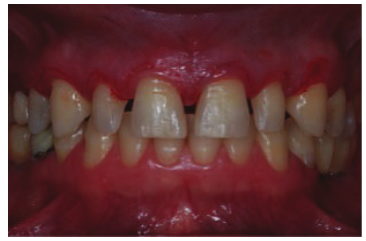
Figure 6: Register of new gingival margin with scalpel.